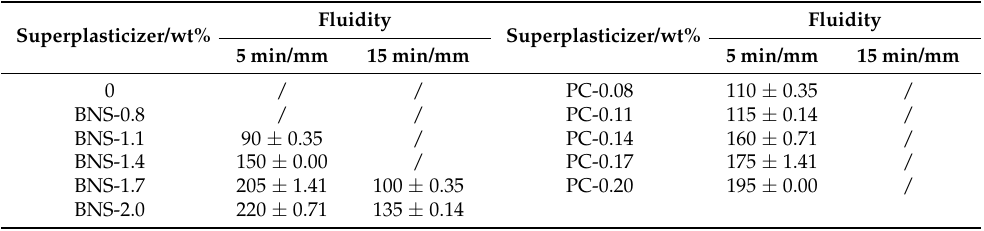
Table 4. 5 min and 15 min fluidity of BNS and PC superplasticizers with different dosages.